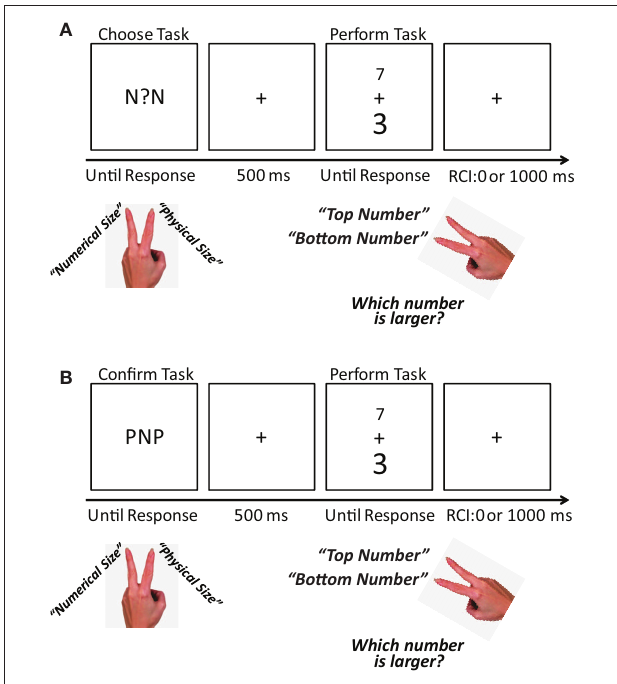
Figure 1 | examples of voluntary and explicit task choice trials used in the experiment. Participants performed a task switching version of the numerical Stroop task, which involved comparing two digits with respect to their numerical size or with respect to their physical size. (A) Each voluntary task choice trial began with the presentation of a central question mark (“?”), which indicated that participants should voluntarily choose which task